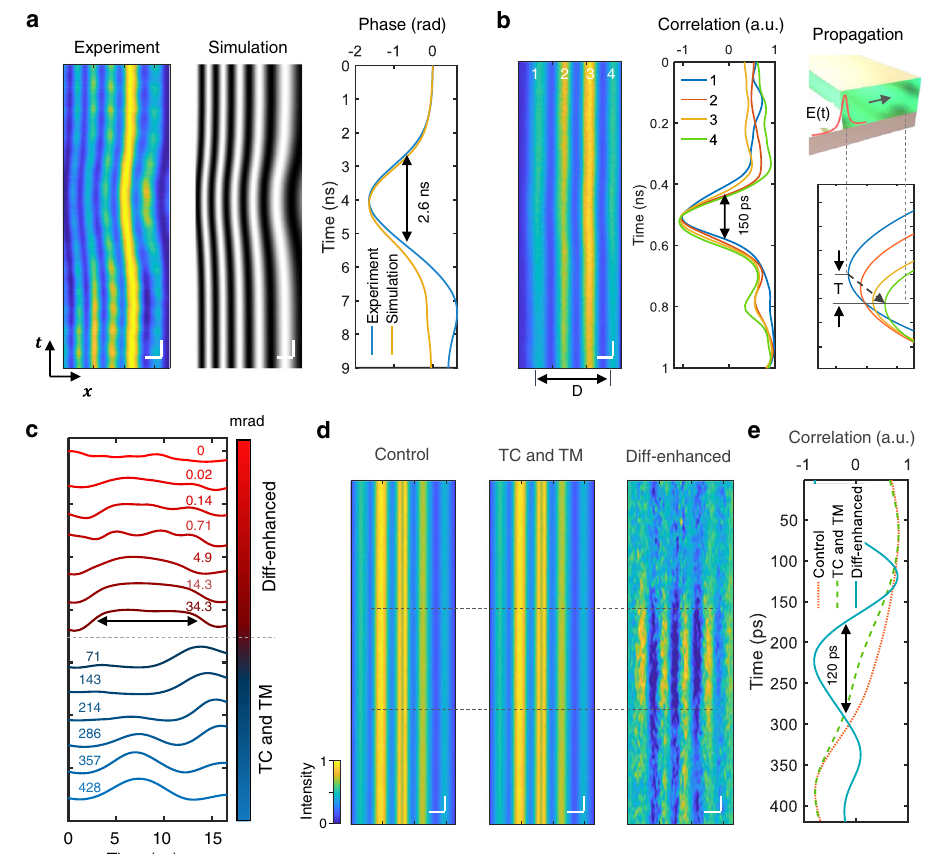
Fig. 2 | Phase sensitivity ofDiff-CUP. a Spatiotemporal interferograms of a 2.6-ns EMP in the LN crystal captured by the streak camera and simulated by the electric fi eld and phase distribution model, and the corresponding temporal phase aver- agingoverthe x direction.Horizontalscalebars,300 µ m.Verticalscalebars,500ps. b Experimentalinterferogram ofa 150-ps propagating EMP and the corresponding temporalcorrelationof Fringes1 – 4.Disthe spatialdistance betweenFringes1and 4. The inset at the bottom right shows the approach to calculate the propagation time, T, of the EMP through the LN (top right). Horizontal scale bar, 300 µ m. Ver- tical scale bar, 50ps. c Quanti fi cation of phase-sensitivity of uncoded Diff-CUP by inducing EMPs with different amplitudes in the LN crystal. Each curve represents a